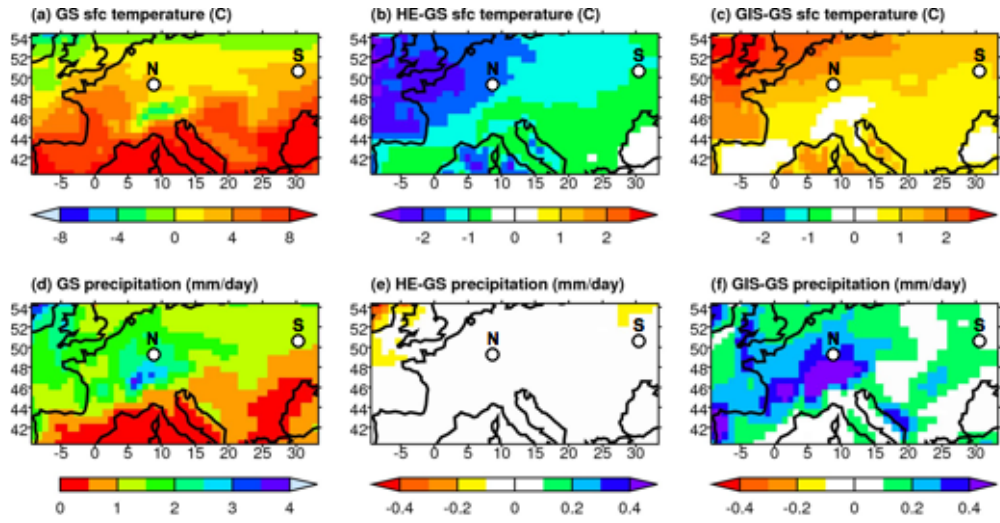
Fig. 6. Surface air temperature (a–c) , and precipitation (d–f) : absolute annual mean values for the reference GS state (left column) and annual mean anomalies HE–GS (middle column) and GIS–GS (right column). (modified from Sima et al., 2009). In white, areas where the differences are not significant to the 95% confidence level (Student’s t-test).